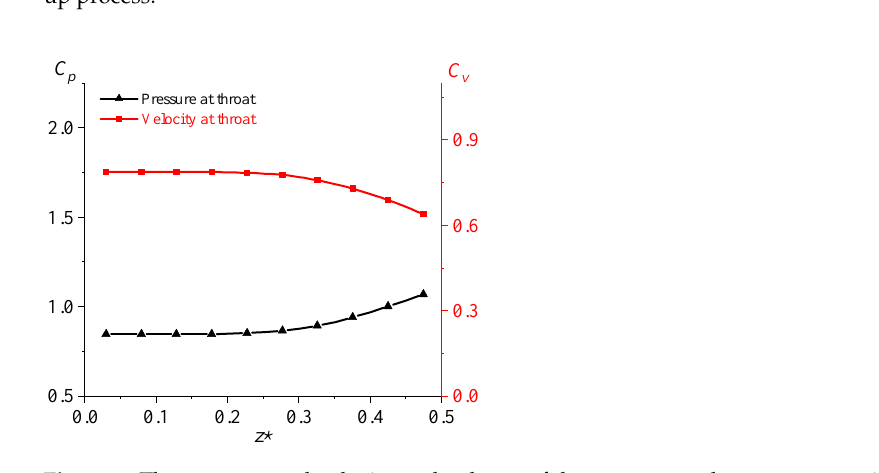
Figure 8. The pressure and velocity at the throat of the narrow gap between two guide vane blades as a function of guide vane height.